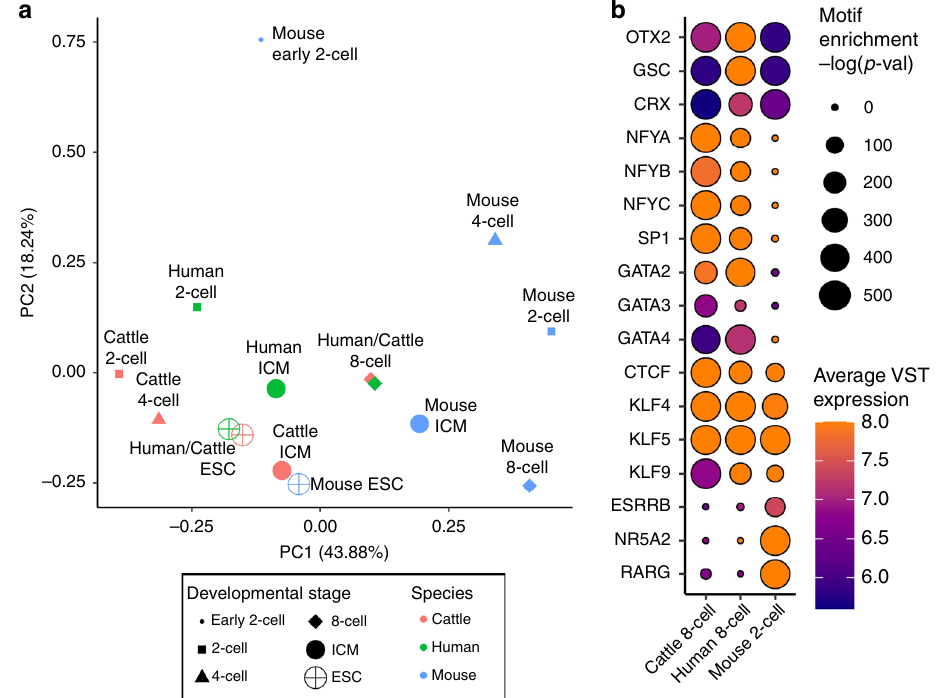
Fig. 8 Comparison of enriched motifs in open chromatin during cattle, human, and mouse preimplantation development. a PCA comparing the percent of ATAC-seq peaks that contained a given TF motif for each cell type and species. b Inference of key regulatory factors during EGA in cattle, human, and mouse, based on enrichment of TF binding motifs in open chromatin and expression of the corresponding TFs. For motif enrichment, binomial test p values reported. Bovine RNA-seq data from Graf et al. 32 human ATAC-seq and RNA-seq data from Wu et al. 18 mouse ATAC-seq and RNA-seq from Wu et al. 17 . Source data are provided as a Source Data fi